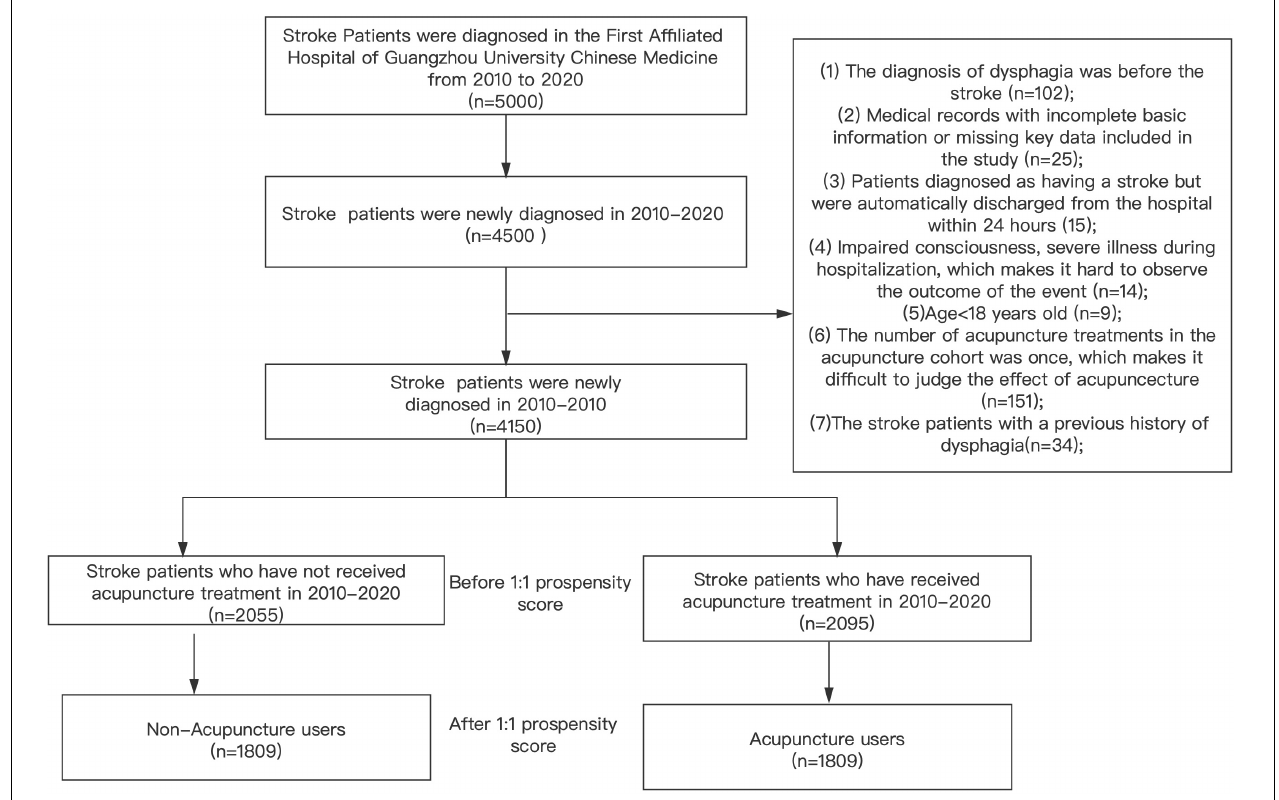
FIGURE 1 | Process of study